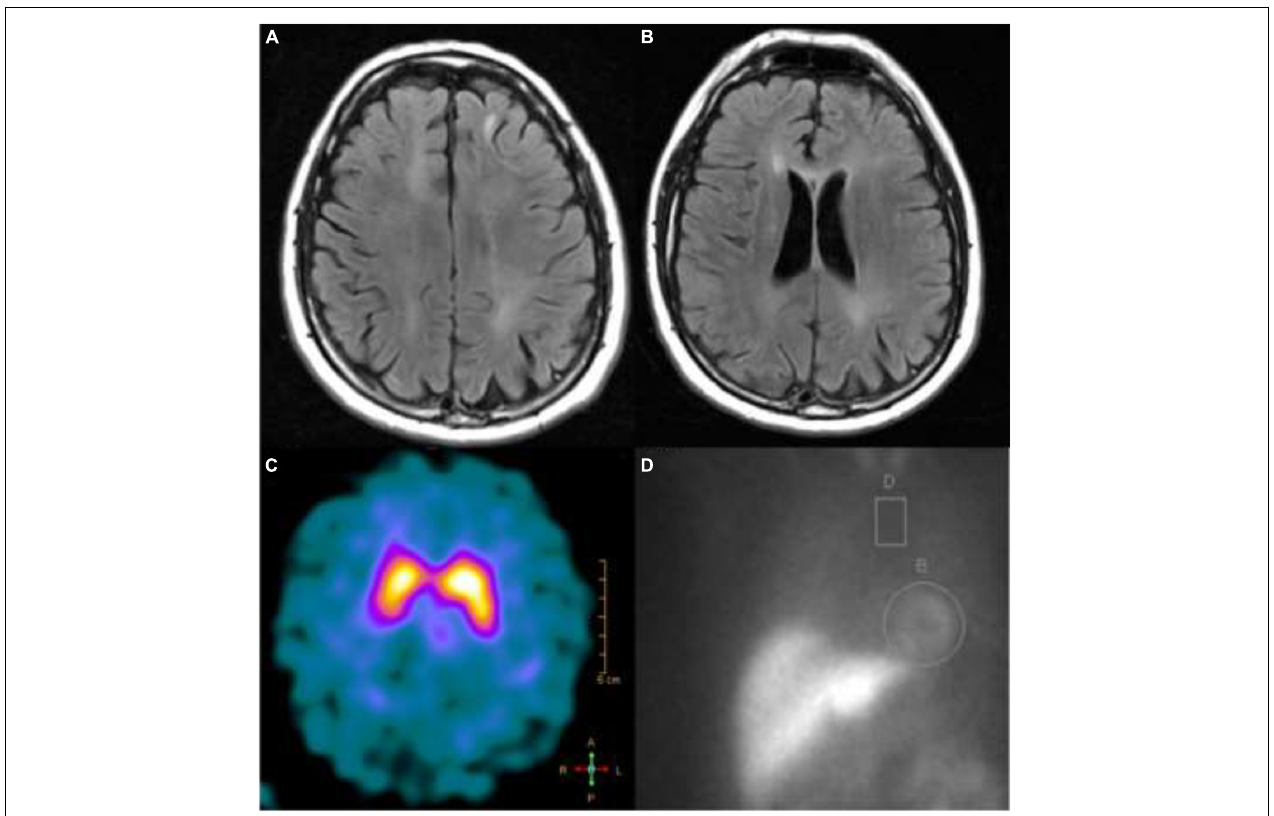
FIGURE 2 | T2-FLAIR MRI showing (A) left frontal juxtacortical hyperintensity and (B) periventricular white matter hyperintensities; (C) a dopamine transporter scan showed reduced tracer uptake in the right putamen; (D) an MIBG scan showing higher than normal ( > 4:1) heart to mediastinum ratio.